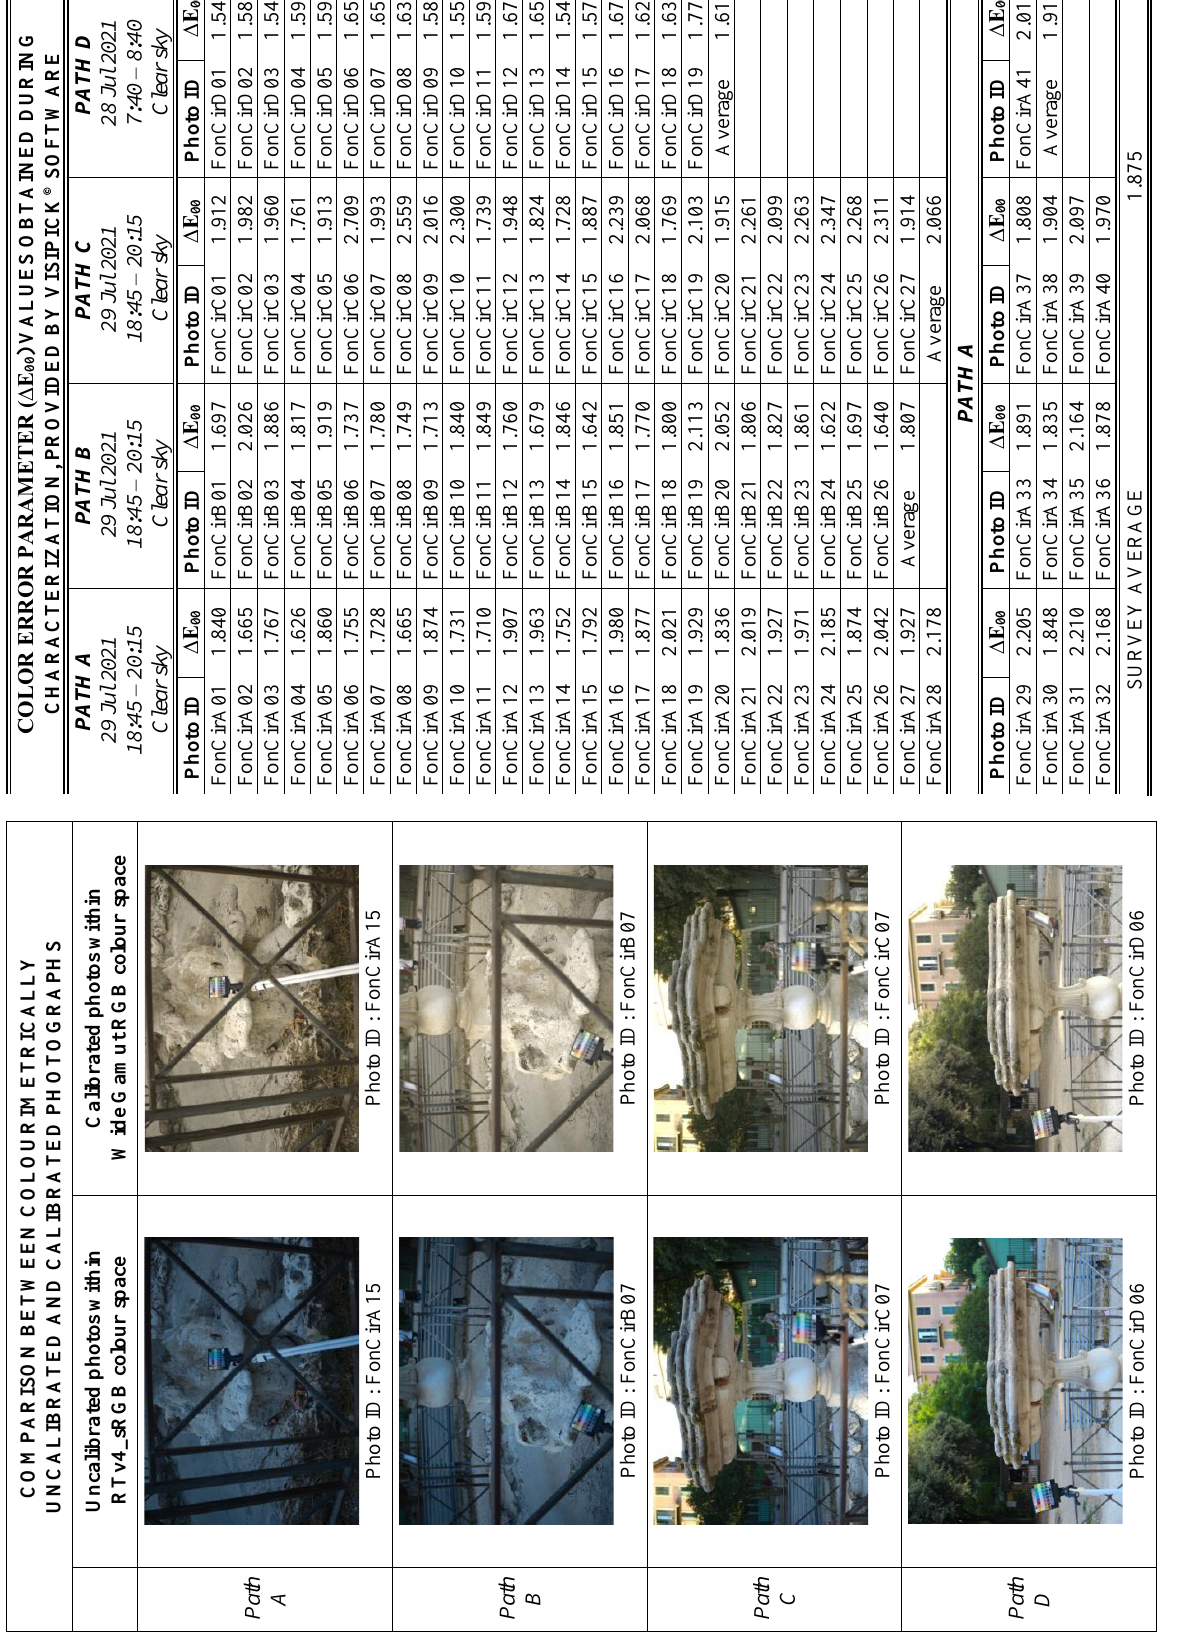
Table 2 . Dataset of Study Case No. 2: the circular fountain in the park of Villa